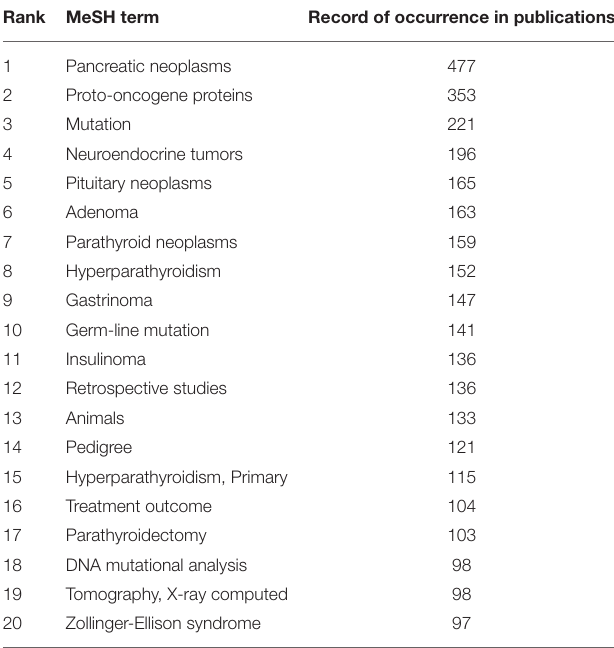
TABLE 1 | Overall ranking of research foci in the past 22